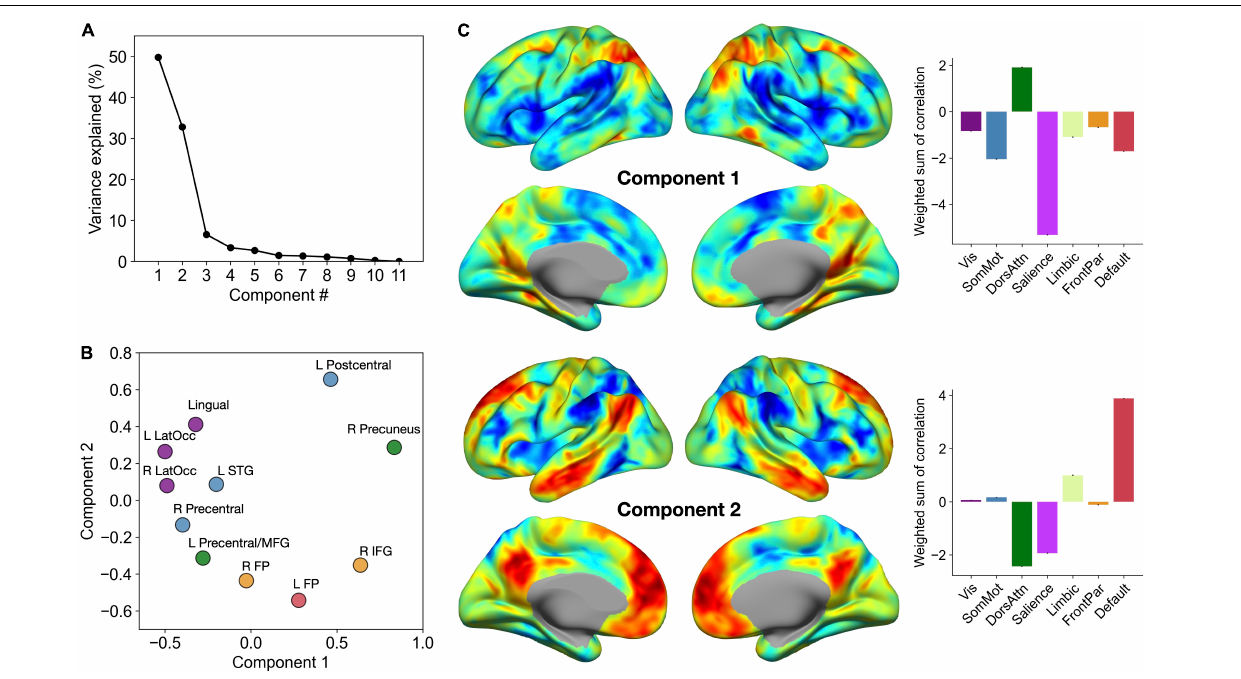
FIGURE 4 | Low dimensional decomposition of brain-behavior correlations reveals two dominant axes of organization. (A) The percentage of variance in the data explained by each component. Note a clear knee in the curve showing variance explained by each component, suggesting that the first two components capture the most relevant aspects of brain-behavior correlation patterns. (B) PC scores of each MVPA seed cluster for the first two components. Each cluster is colored by the corresponding functional network label as determined by maximal spatial overlap with canonical network boundaries (Yeo et al., 2011). (C) Sums of all 11 correlation maps weighted by the respective PC scores. Bar graphs on the right show the breakdown of these voxel-wise weighted sum scores by the seven canonical networks of the cerebral cortex.